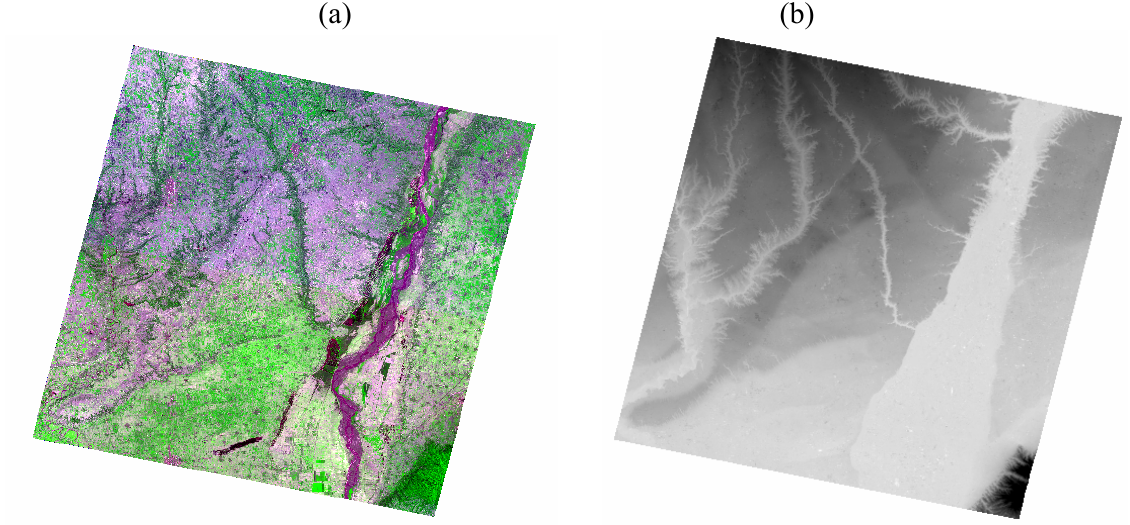
Figure 1 . (a) The false color image and (b) DEM of ASTER (RGB: band 132) for the study area, dated on 8 June